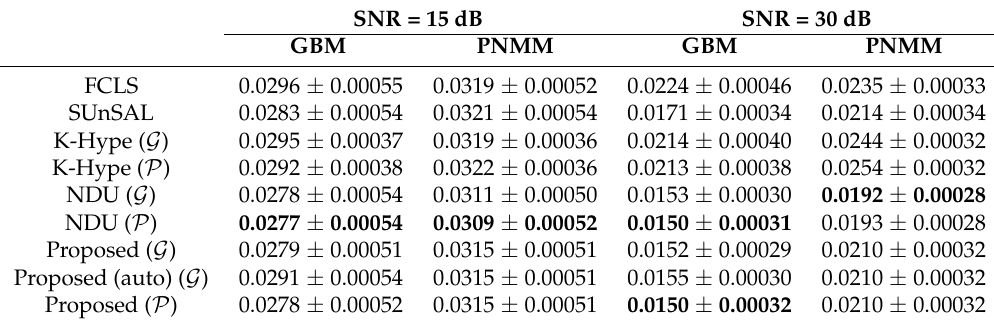
Table 1. RMSE comparison of S 1 .